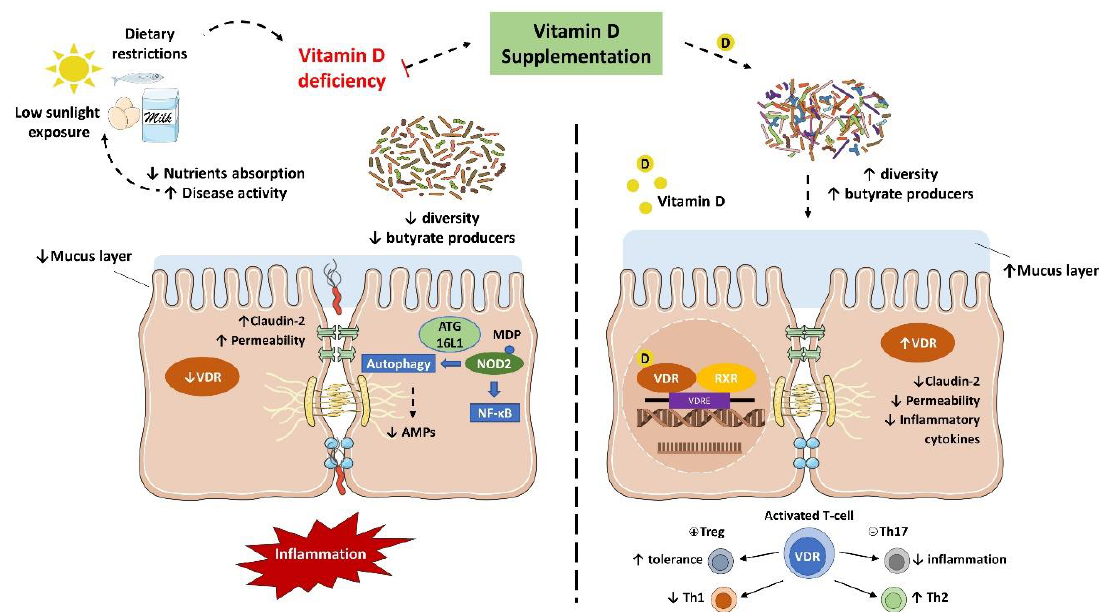
Figure 3. Vitamin D/VDR is involved in the genetic, environmental, immune, and microbial aspects of inflammatory bowel disease (IBD). Thus, the vitamin D supplement and activation of VDR could be considered as a multifunctional factor in IBD treatment.